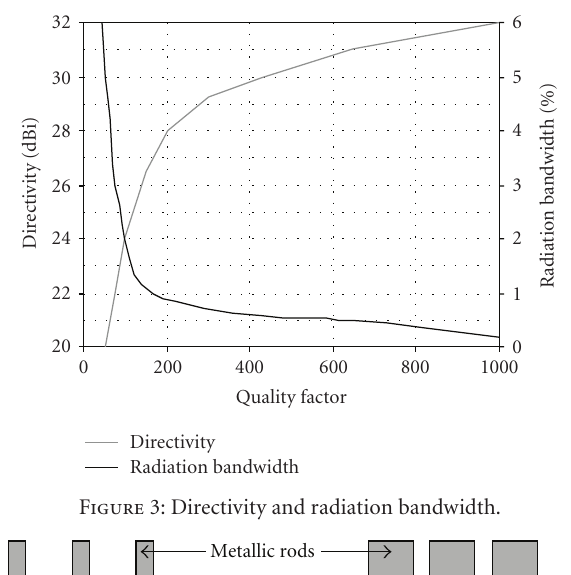
Figure 2: Dispersion diagram of the EBG antenna.